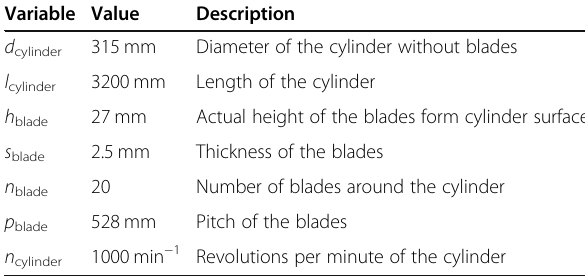
Table 1 Rizzi LW 3200 Shaving Machine Characteristics